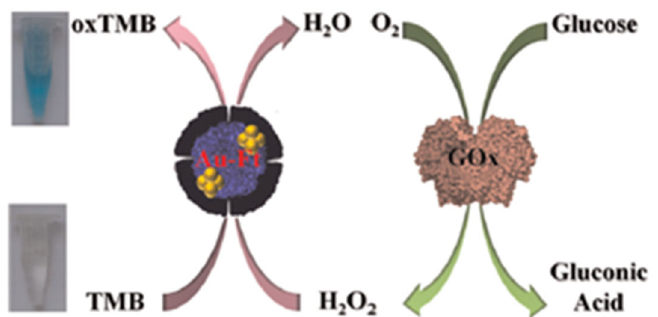
Figure 14. Glucose determination principle using a Ft–Au nanozyme. Reprinted with permission from [59]. Copyright © 2015 Elsevier.